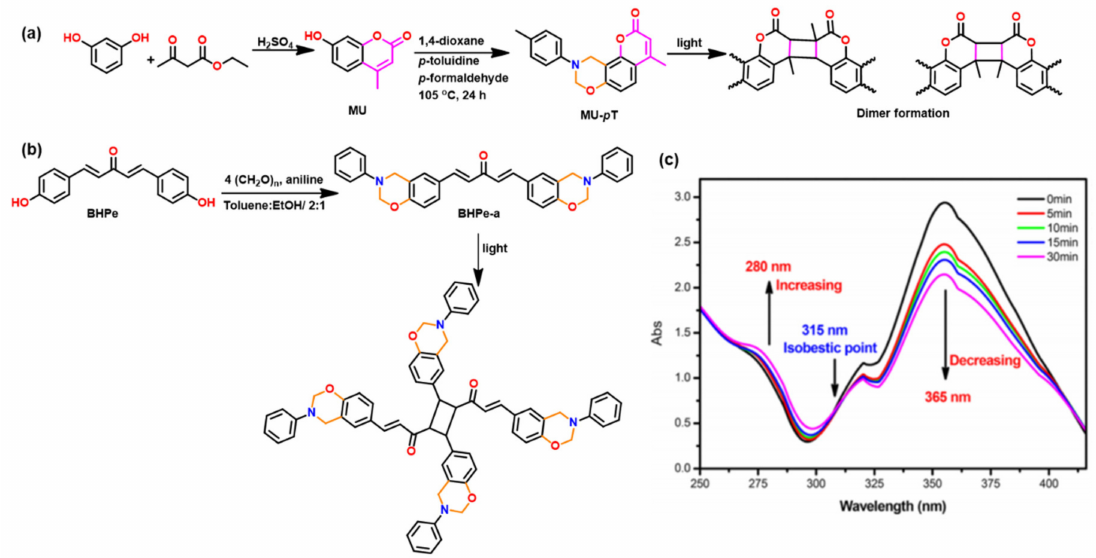
Figure 18. Synthesis of photoreactive unit: ( a ) coumarin [208] and ( b ) bis-benzylidene containing benzoxazine monomers and their light mediated dimerization [213]. ( c ) UV absorption spectra of BHPe-a in DMAc at a concentration of 0.8 mg/40 mL after irradiation at 365 nm for various periods of time [213]. Copyright 2017. Reproduced with permission from American Chemical Society.